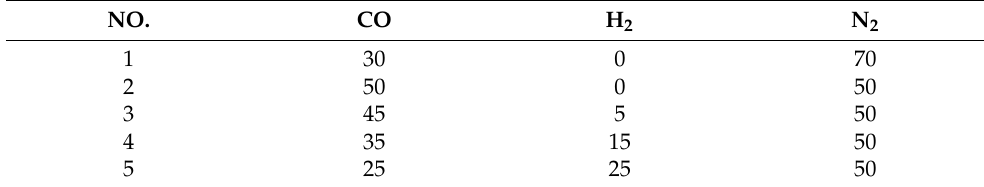
Table 2. Composition of reducing gas,